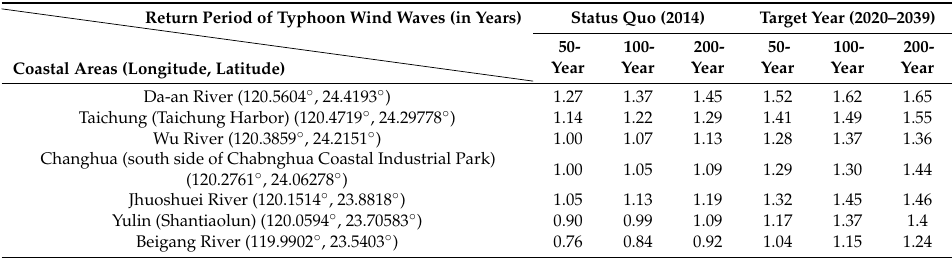
Table 3. Maximum storm surge deviations of different return periods for the target’s future. Latitude)Return Period of Typhoon Wind Waves (in Coastal Areas (Longitude,